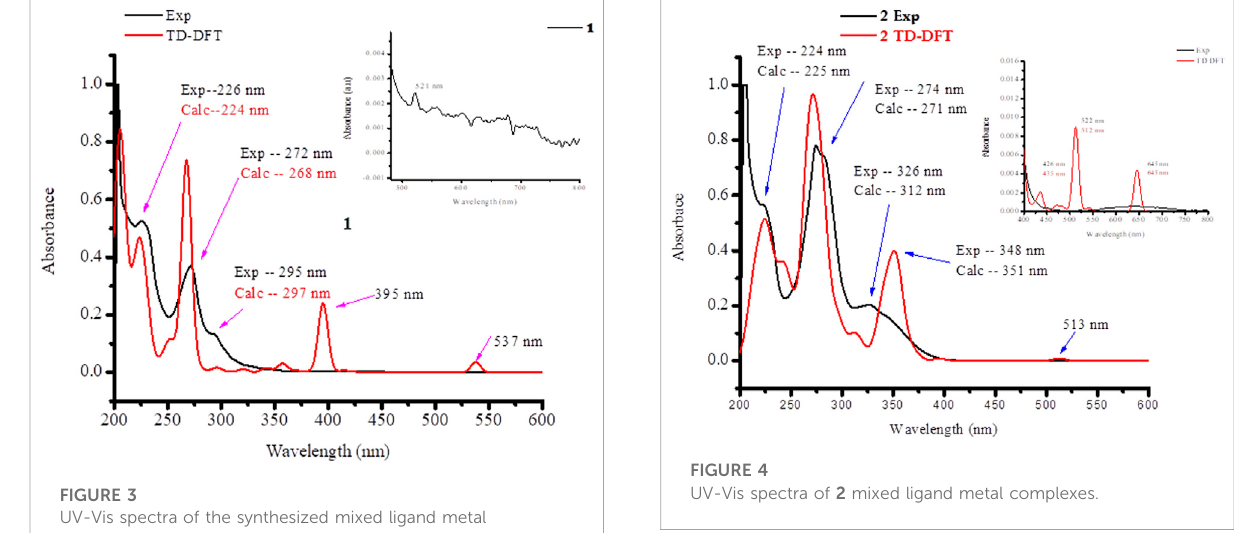
FIGURE 4 UV-Vis spectra of 2 mixed ligand metal